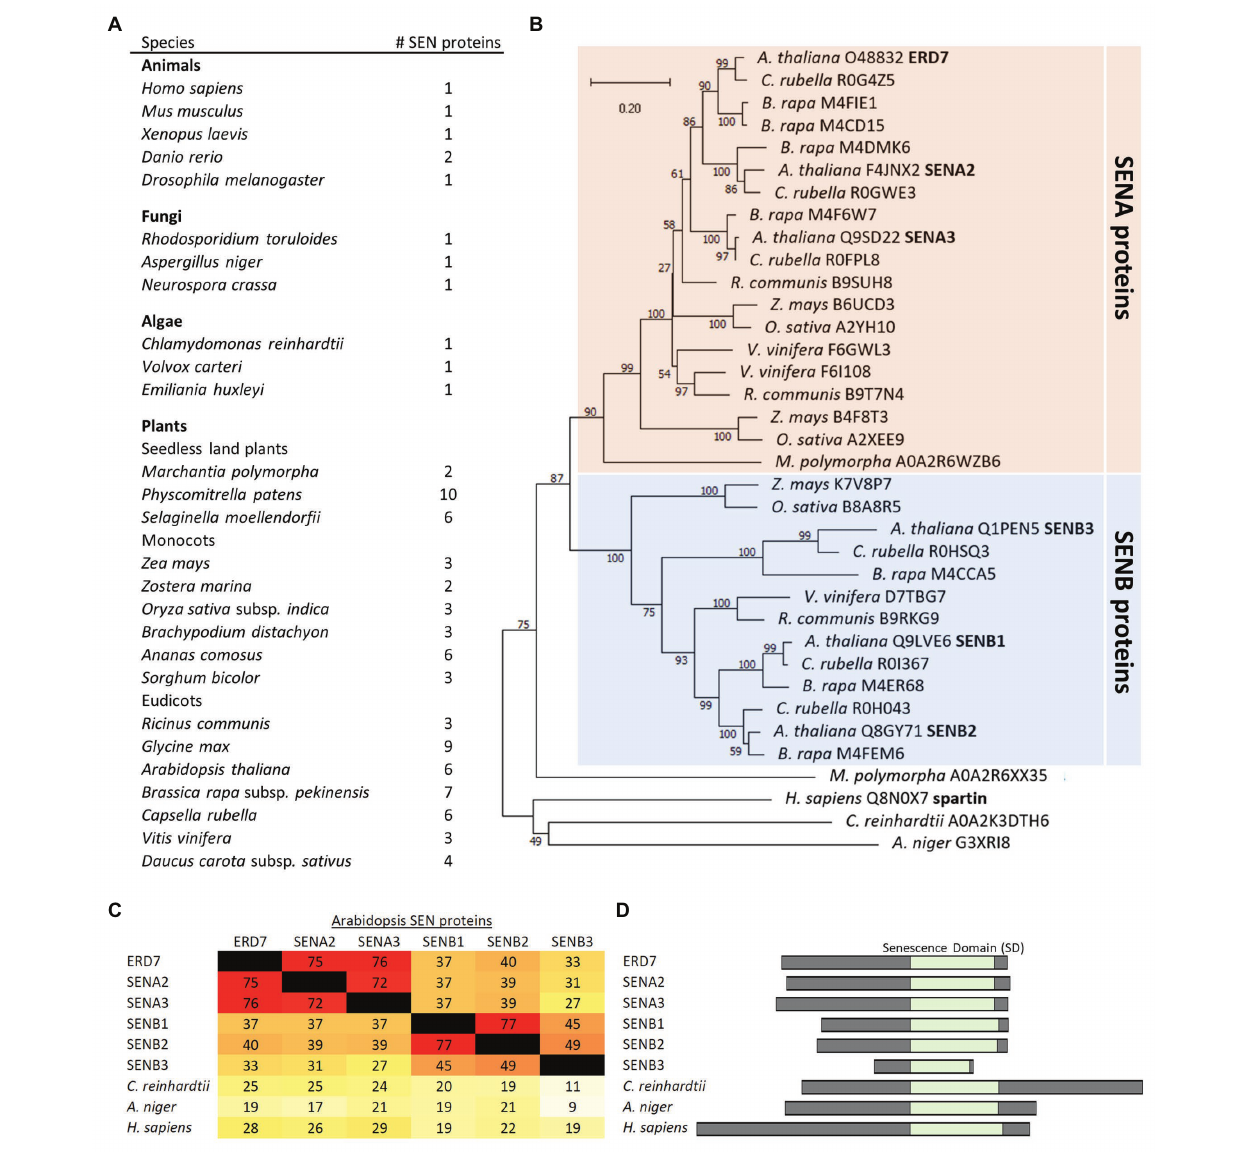
FIGURE 3 | Comparison of SEN protein families in plants and other evolutionarily-diverse species. (A) Shown are the number of proteins in selected species from plants, animals, fungi, and algae that are annotated to contain an SD, based on the InterPro domain database for SDs (InterPro entry: IPR009686), and ruling out redundant entries and splice isoforms based on the UniProt annotations for each protein. (B) Phylogenetic tree based on the SD sequences of SEN proteins from selected plant and non-plant species, obtained from the Uniprot or Phytozome databases, and constructed with the neighbor-joining method using MEGA-X (Kumar et al., 2018). Bootstrap values are indicated beside each branch point. The scale bar represents the number of amino acid substitutions per site. Note that, with exception of one protein from M. polymorpha , all of the plant SEN proteins shown group into either the SENA or SENB protein subfamilies. Each protein is listed by its species and Uniprot accession number. Also indicated in bold are the six SENA/B proteins, including ERD7, in Arabidopsis, as well as human spartin. (C) A heat map displaying the primary sequence identity (as a percentage) among the SDs of the six Arabidopsis SENA/B proteins and selected SEN proteins from other non- plant species, all which were calculated based on a ClustalO multiple sequence alignment. Darker (red) colors reflect higher sequence identities, while lighter (yellow) colors reflect lower sequence identities, consistent with the corresponding percent identities shown in each panel. (D) Schematic representations of the six Arabidopsis SENA/B proteins, as well as selected SEN proteins from algae, fungi, and animals (i.e., Chlamydomonas reinhardtii , Aspergillus niger , and human), depicting the relative location (and length) of their SDs and adjacent N- and C-terminal